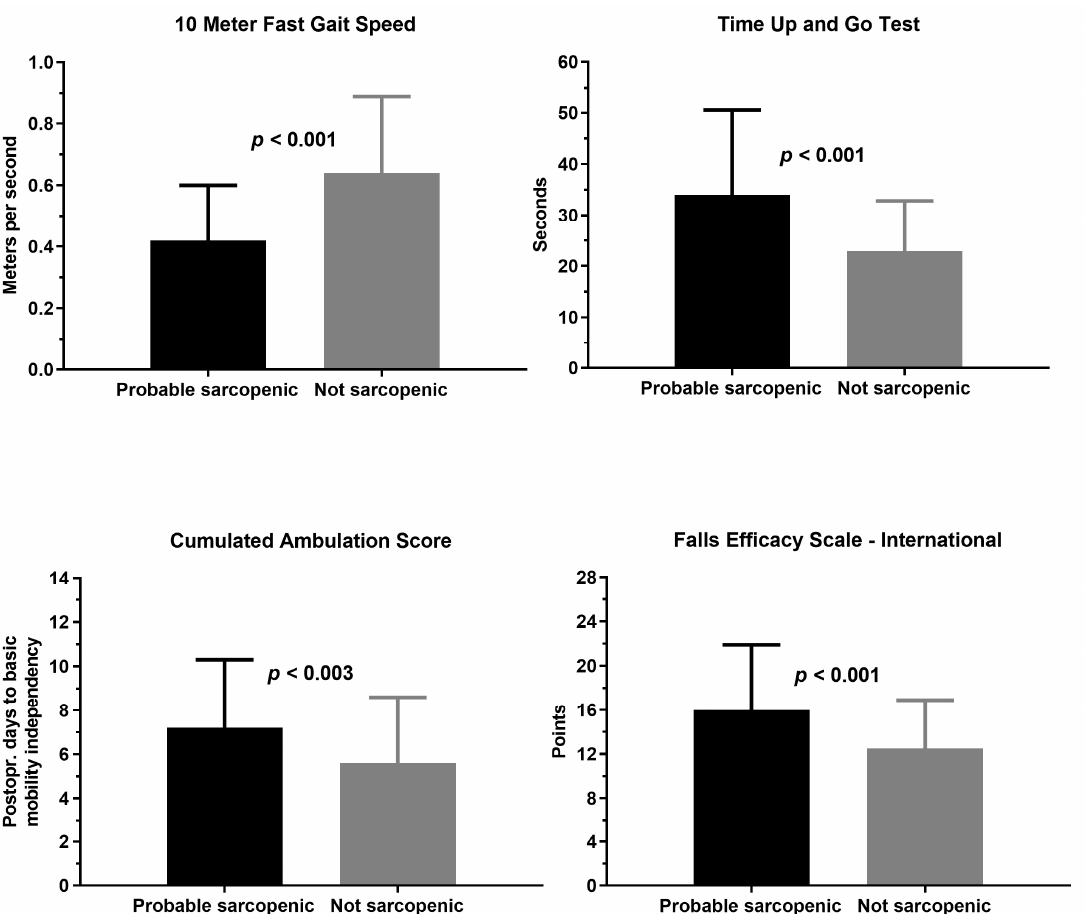
Figure 3. Association of a probable sarcopenic status according to lower limb strength measures and health-related outcomes. Knee extension strength group, n = 150. Boxes and whiskers are mean, SD.